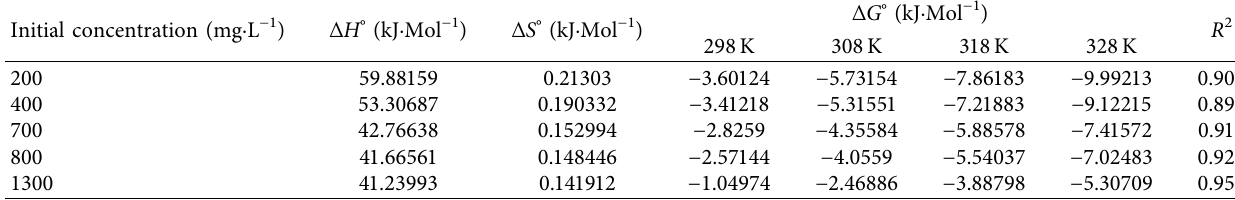
− ions sorption by ZCOBLP. 4 − sorption by ZCOBLP. 4